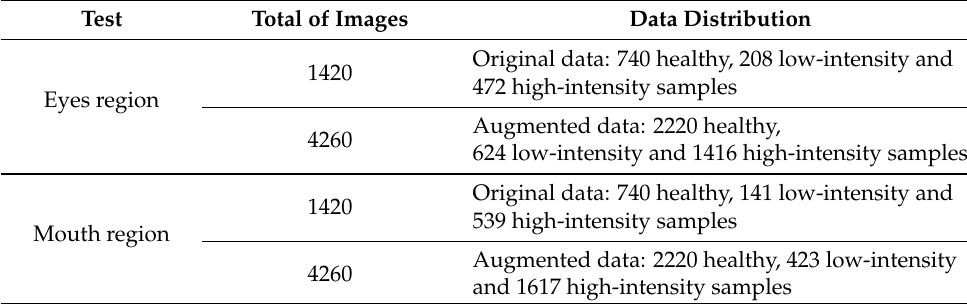
Table 11. Data distribution for the prediction of three palsy levels.